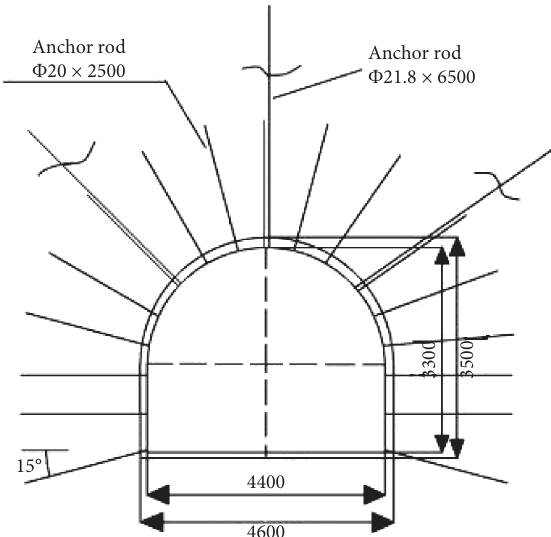
Figure 2: Cross-section design of the supporting scheme of 11123 floor gas drainage roadway.